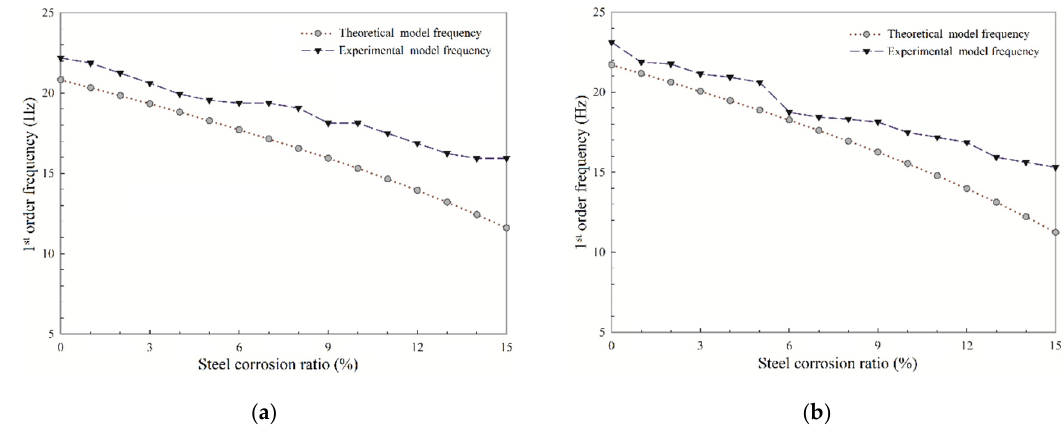
Figure 11. Comparison of theoretical and experimental first-order frequency: ( a ) 1 # RC beam; ( b ) 2 # RC beam.